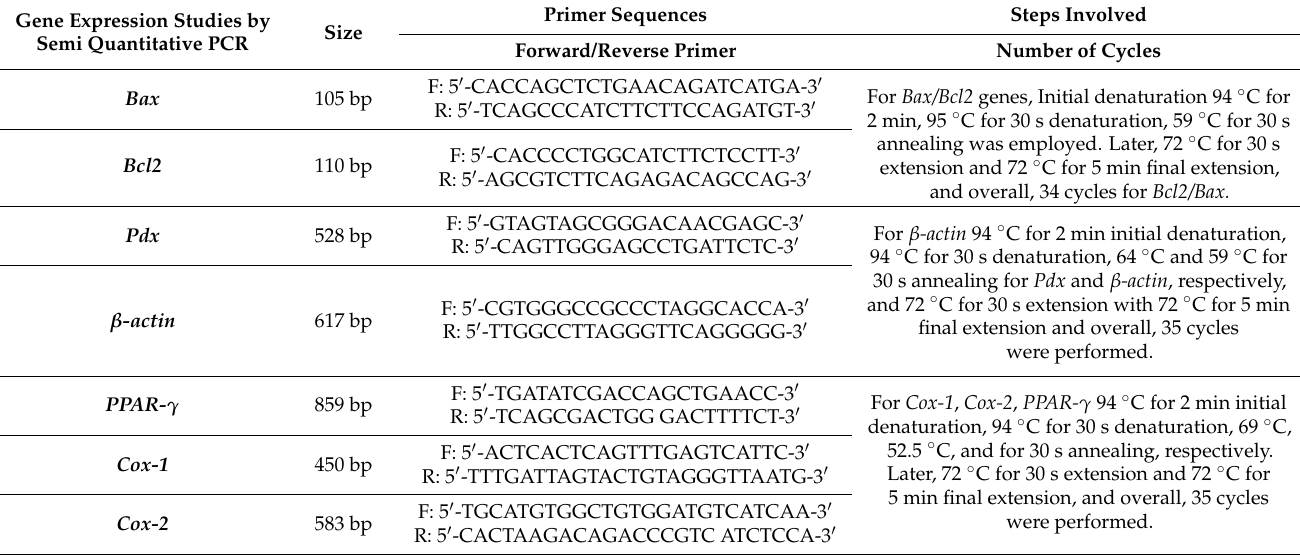
Table 3. PCR primers (F: forward primer, R: reverse primer) and size of amplicon along with steps in the PCR cycle. Gene Expression Studies by Semi Quantitative